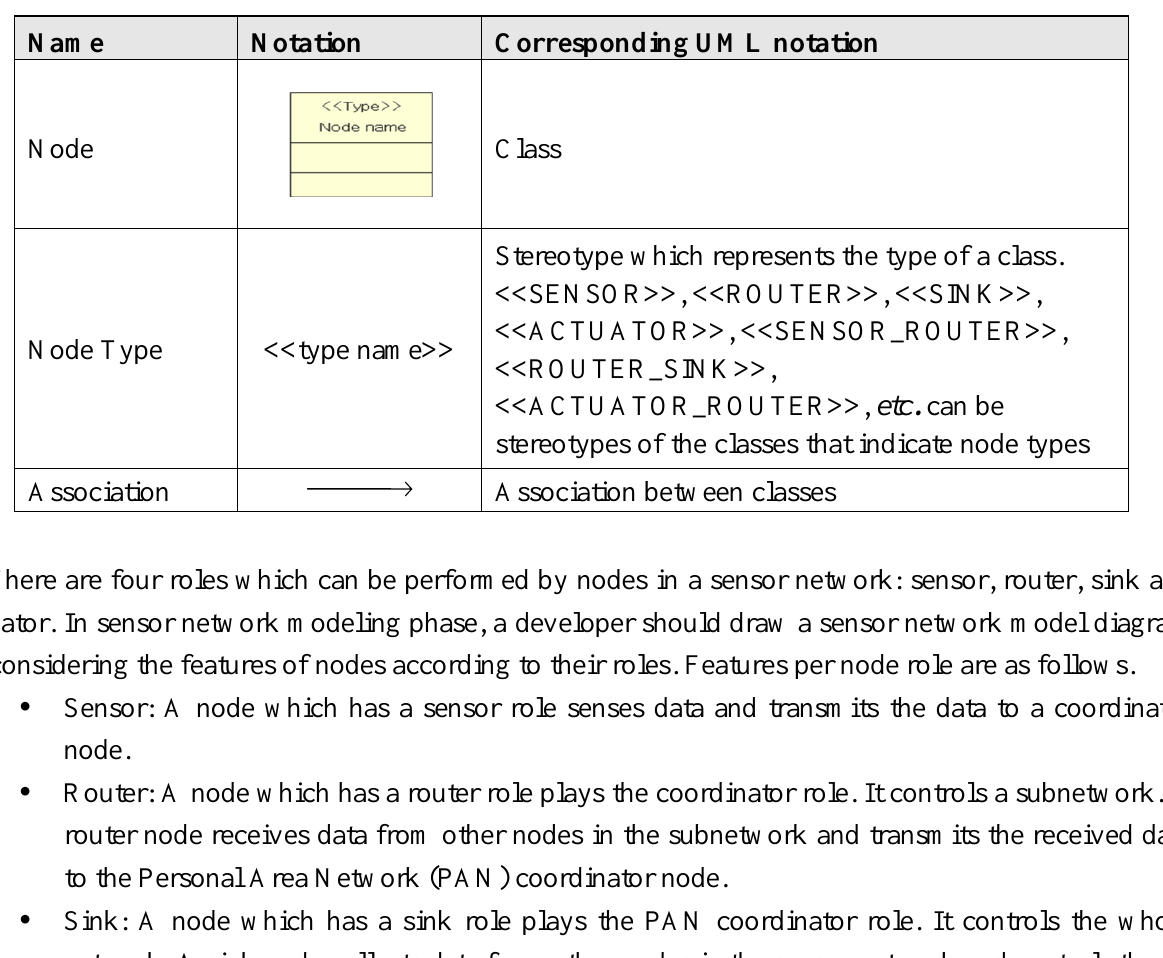
Table 1. The notation for the sensor network